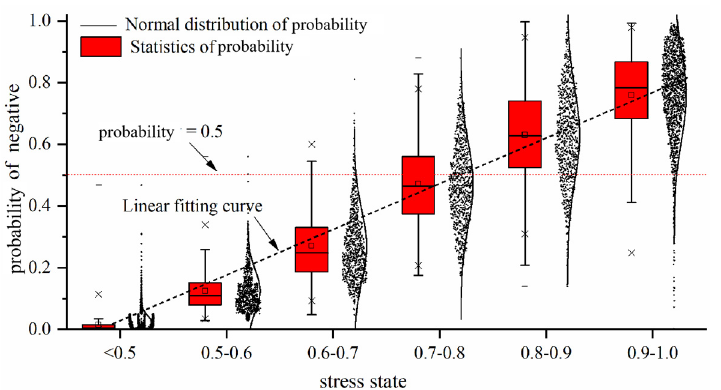
Figure 10. Probability distribution of AIEFPC prediction for the AE sample hazardousness corre- sponding to different stress states.